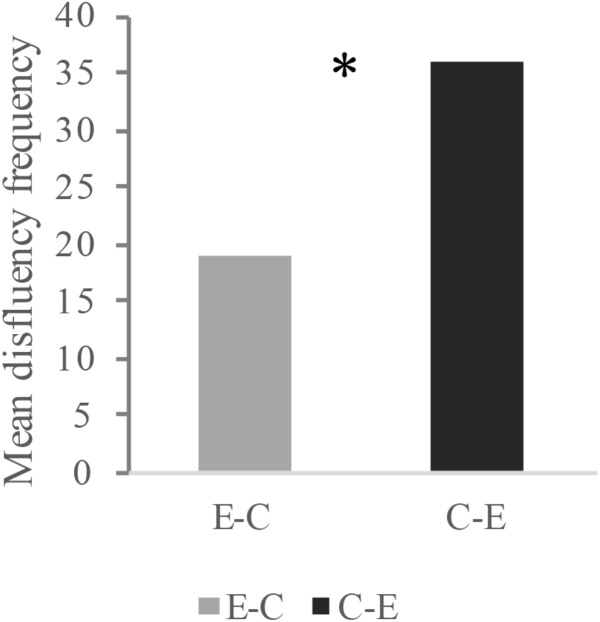
Disfluency frequency of two interpreting directions (average number over the participants). ∗Indicates where significant differences exist.